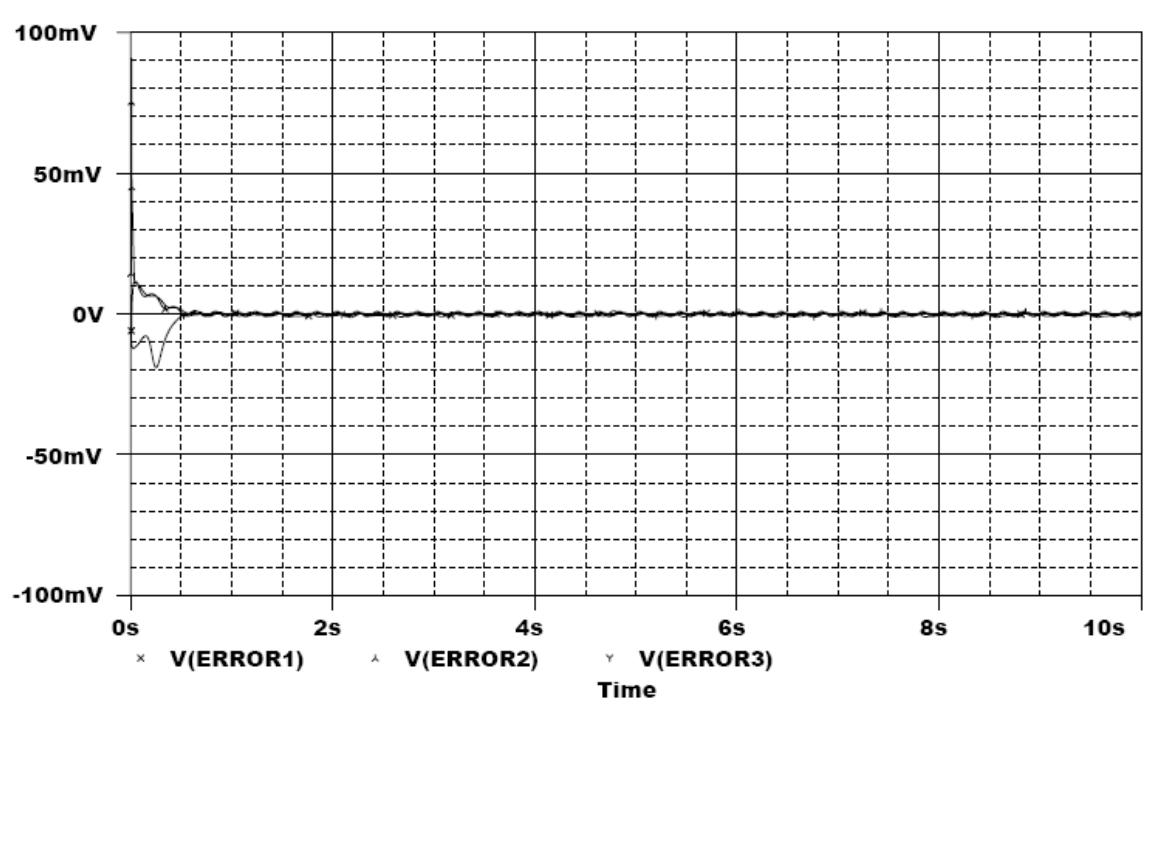
and state x m s